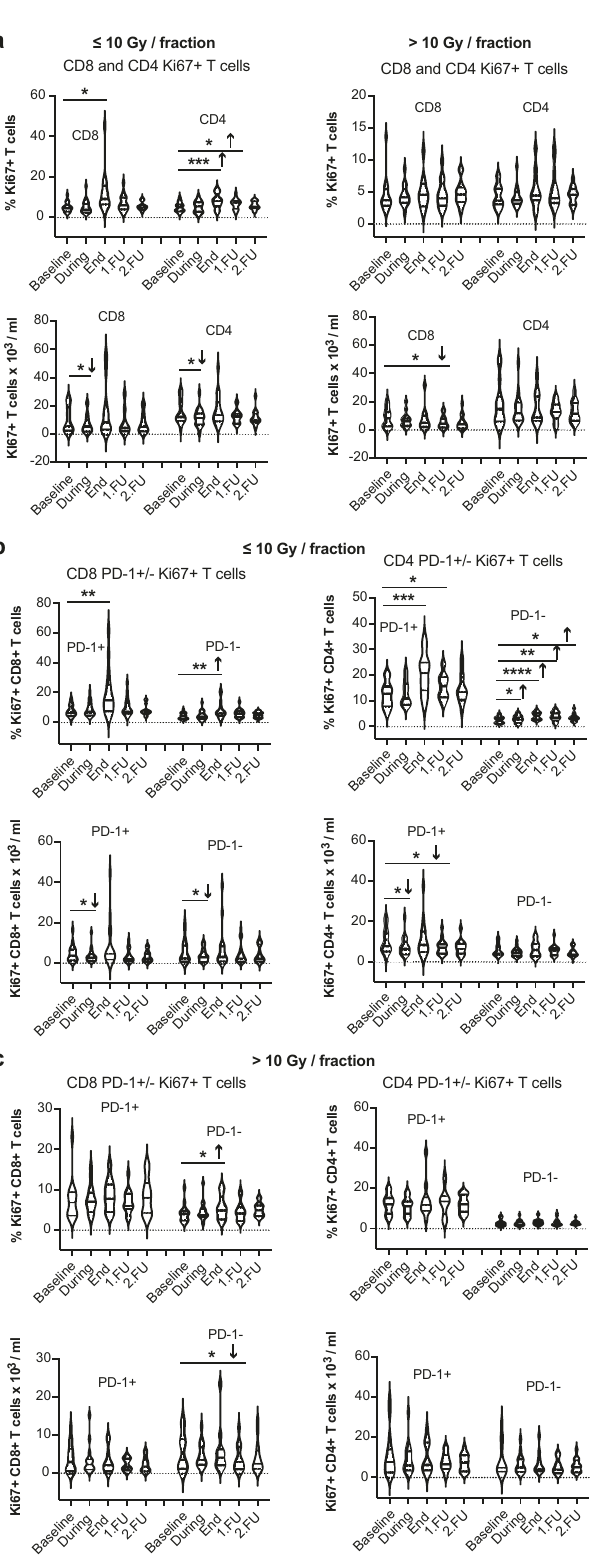
Fig. 2 SBRT dose-dependent effects on CD8 + and CD4 + circulat- ing T-cell proliferation post-treatment in early-stage NSCLC patients. a Fraction and absolute peripheral blood cell numbers of Ki-67 + CD8 + and Ki-67 + CD4 + T-cells after SBRT using doses of ≤ 10 Gy (left) versus >10 Gy (right). b Fraction and absolute peripheral blood cell numbers of Ki-67 + PD-1 + versus Ki-67 + PD-1 − CD8 + and CD4 + T-cells after SBRT using doses of ≤ 10 Gy. c Fraction and absolute peripheral blood cell numbers of Ki-67 + PD-1 + / Ki- 67 + PD-1 − CD8 + and CD4 + T-cells with SBRT using doses >10 Gy. * p ≤ 0.05, ** p < 0.01, *** p < 0.001, **** p < 0.0001 from mixed effects model for repeated measures with Geisser-Greenhouse correction and Benjamini, Krieger, and Yekutieli for the false discovery rate, two-sided. Arrows indicate the direction of change. Data are shown as median values (center lines) and interquartile